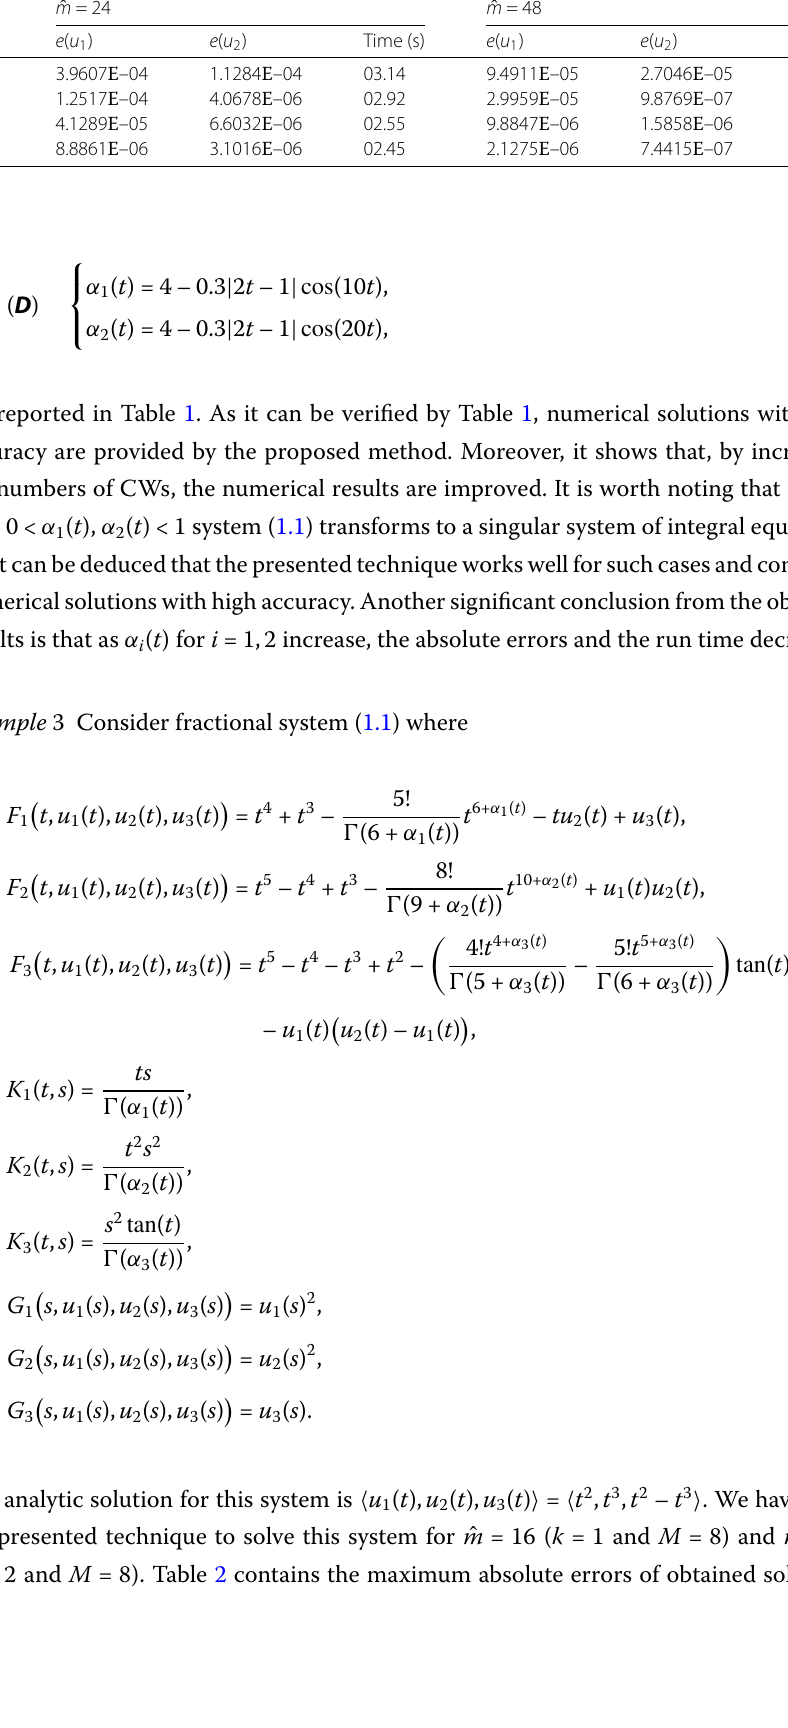
Table 1 The maximum absolute errors and the run time in Example 2